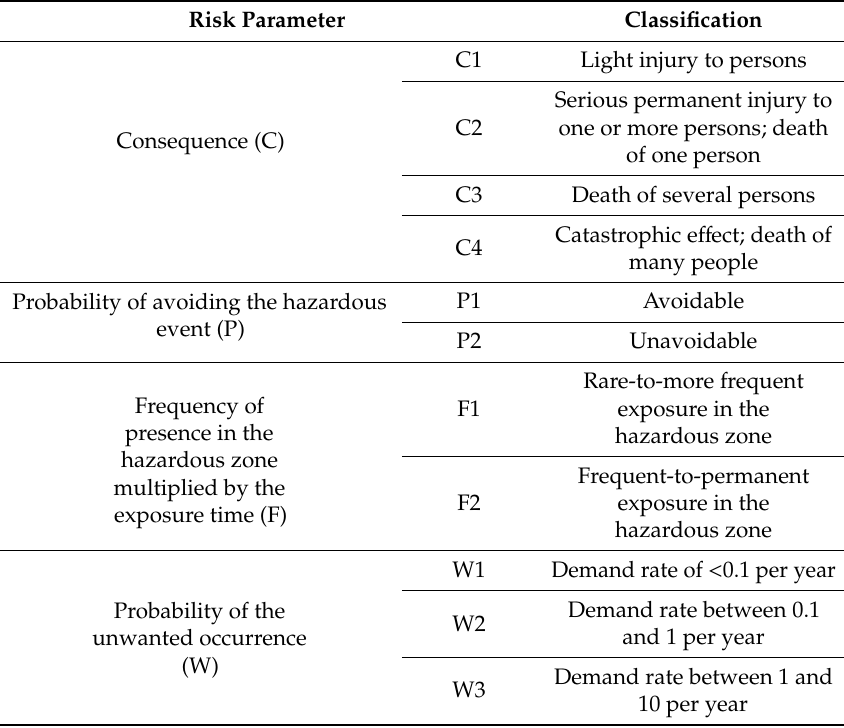
Table 10. Risk parameters in the SIL